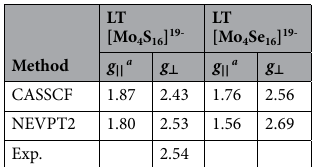
Table 2. Calculated g factors for LT [Mo 4 X 16 ] 19- ( X = S, Se) cluster models (CAS(11e,12o)). a g || refers to the cubic [111] axis (see also Fig. 4).